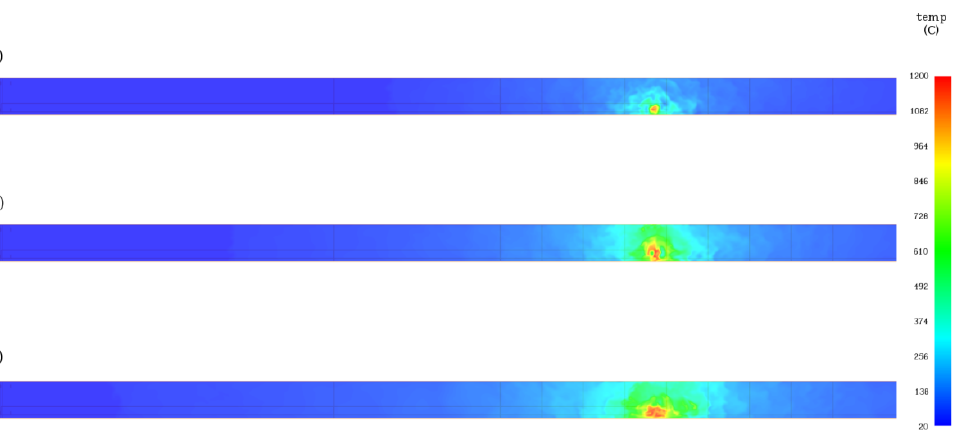
Figure 8. Tunnel ceiling (z = 7 m) temperatures for each scenario at the jet fan activation time frame: ( a ) Scenario A at +180 s, ( b ) Scenario B at +300 s, and ( c ) Scenario C at +480 s after the fire accident.